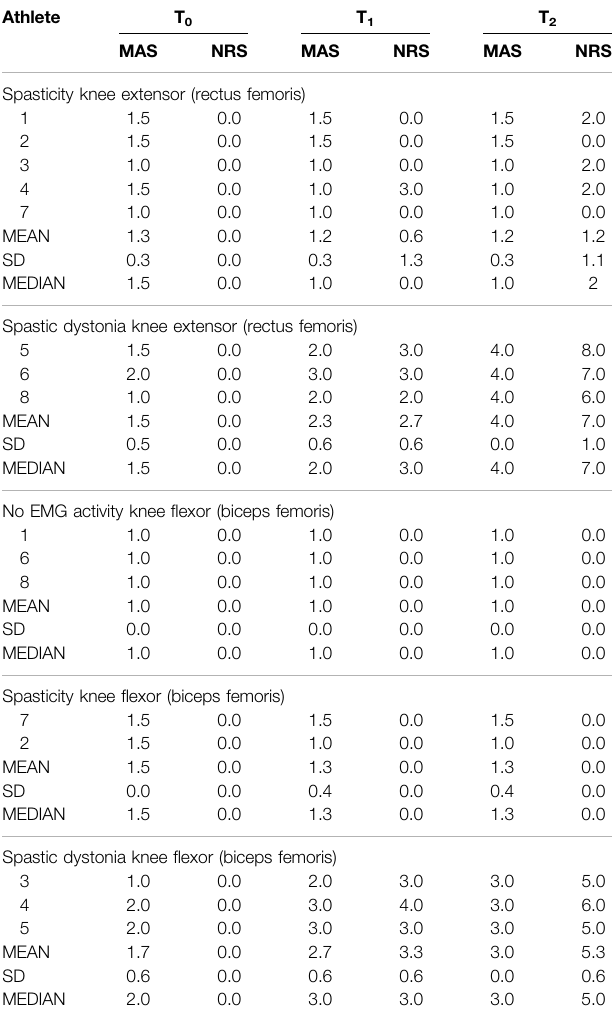
TABLE4| ValuesintheModi fi edAshworthScale(MAS)andNumericRatingScale for the pain (NRS) along the three time points (T 0 , T 1 and T 2 ). Athlete T 0 T 1